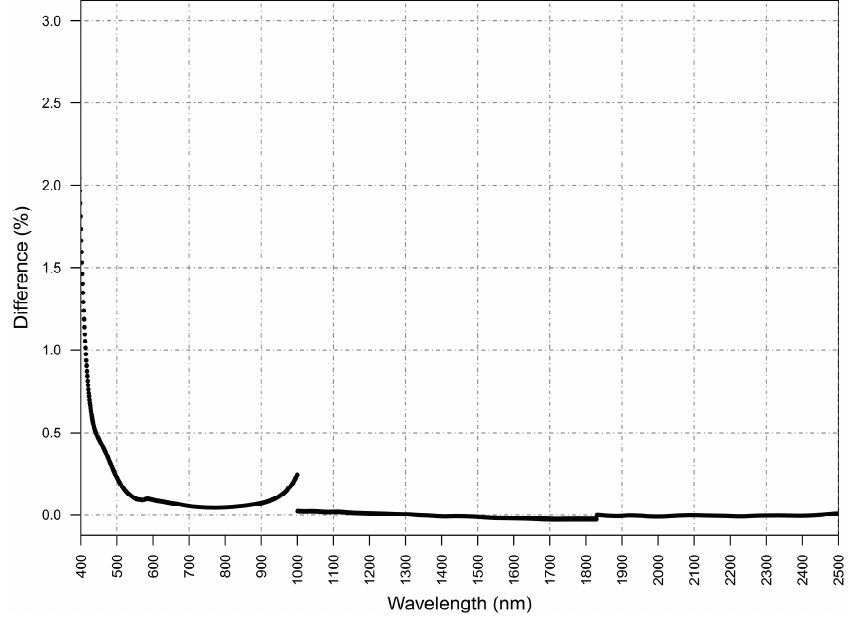
Figure 5. Percentage difference in reflectance of the adopted white reference panel before and after the measurement